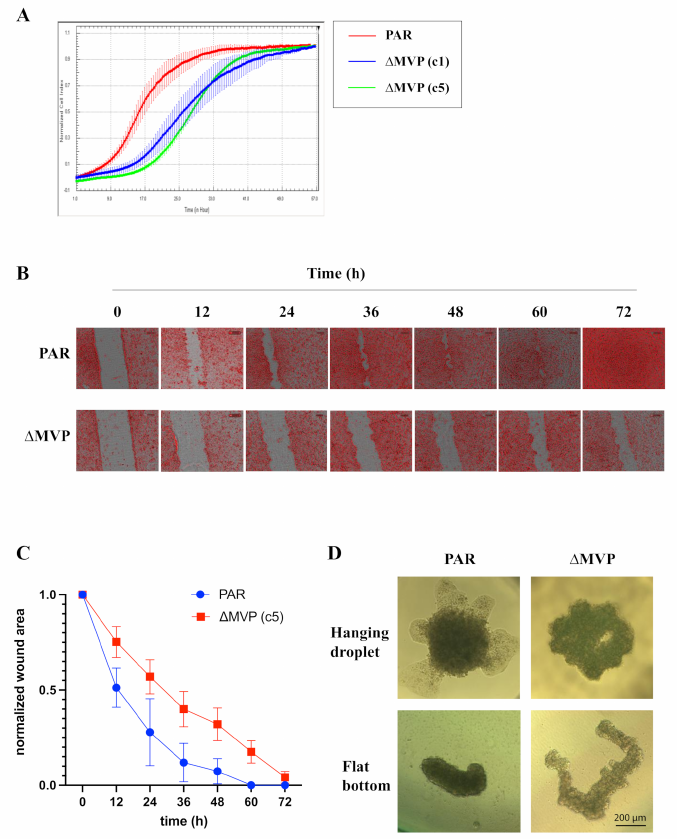
Figure 5. Analysis of migration and morphology of U2OS parental cells and MVP-negative cells (U2OS- ∆ MVP). ( A ) Cell migration analysis using the xCELLigance Real-Time Cell Analysis Sys- tem. Three different cell types were analyzed (parent U2OS, U2OS- ∆ MVP, c1 and c5 clones). ( B ) Assessment of cell migration using the wound healing technique of U2OS and U2OS- ∆ MVP cells (c5 clone). ( C ) Parametric analysis of the results obtained from cell migration using the wound healing technique. ( D ) Visualization of the morphology of parental U2OS-based and MVP-negative U2OS-based spheroids and using two 3D cultures techniques: hanging drop and flat